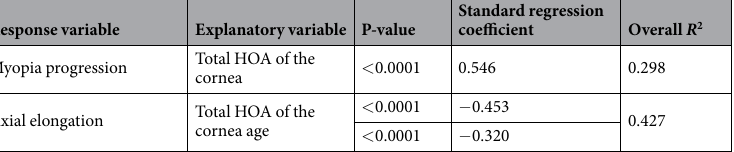
Table 4. Factors affecting myopia progression and axial elongation in multiple regression analysis. HOA = higher-order aberration.